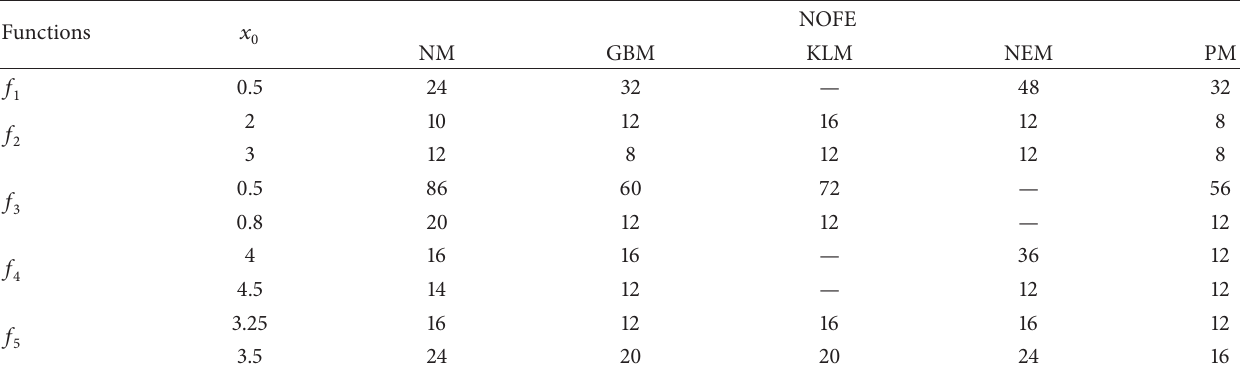
Table 2: Comparison of number of function evaluations